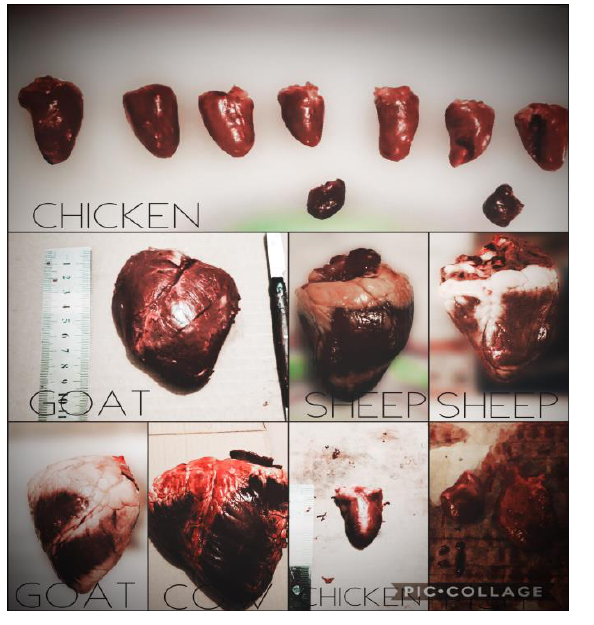
Figure 5. DTI of a healthy volunteer with STE approach using (A) multiple breath-holds (BH) and (B) a diaphragmatic navigator (NAV) during free breathing. In both cases, the identical three short-axis slices were imaged and the tensor field was represented with superquadric glyphs color coded by HA. The qualities of the BH and NAV approaches appear fairly similar. Methods:Macroscopically (Anatomically): In this study 100-heart (fish, chicken, goat, sheep and cow) were dissected and analyzed (Figure 6). Figure 6. Multiple hearts of different species (fish, chicken, sheep, goat and cow); which included in the study.